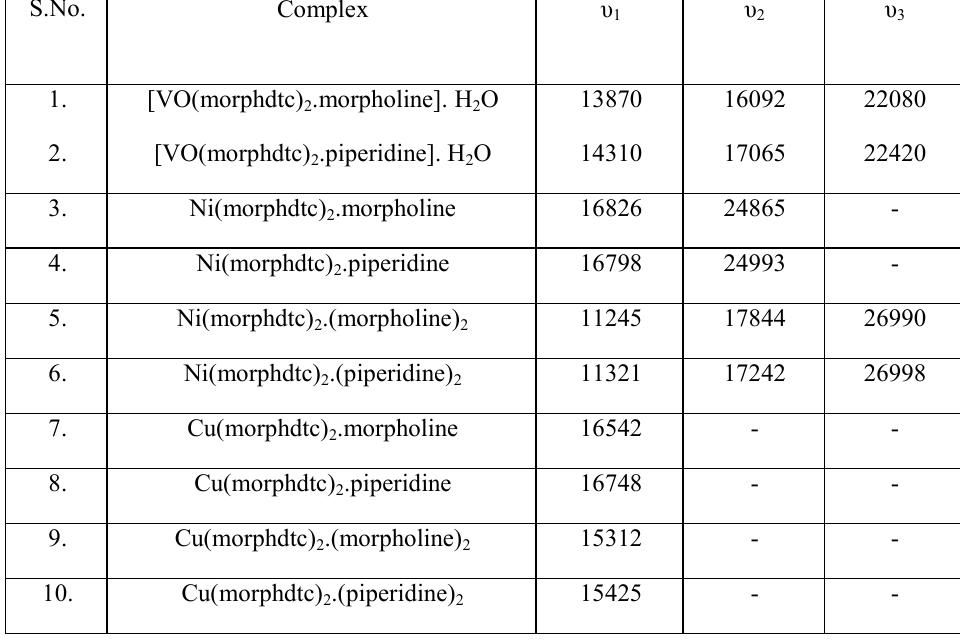
Table 3. Electronic spectra of the